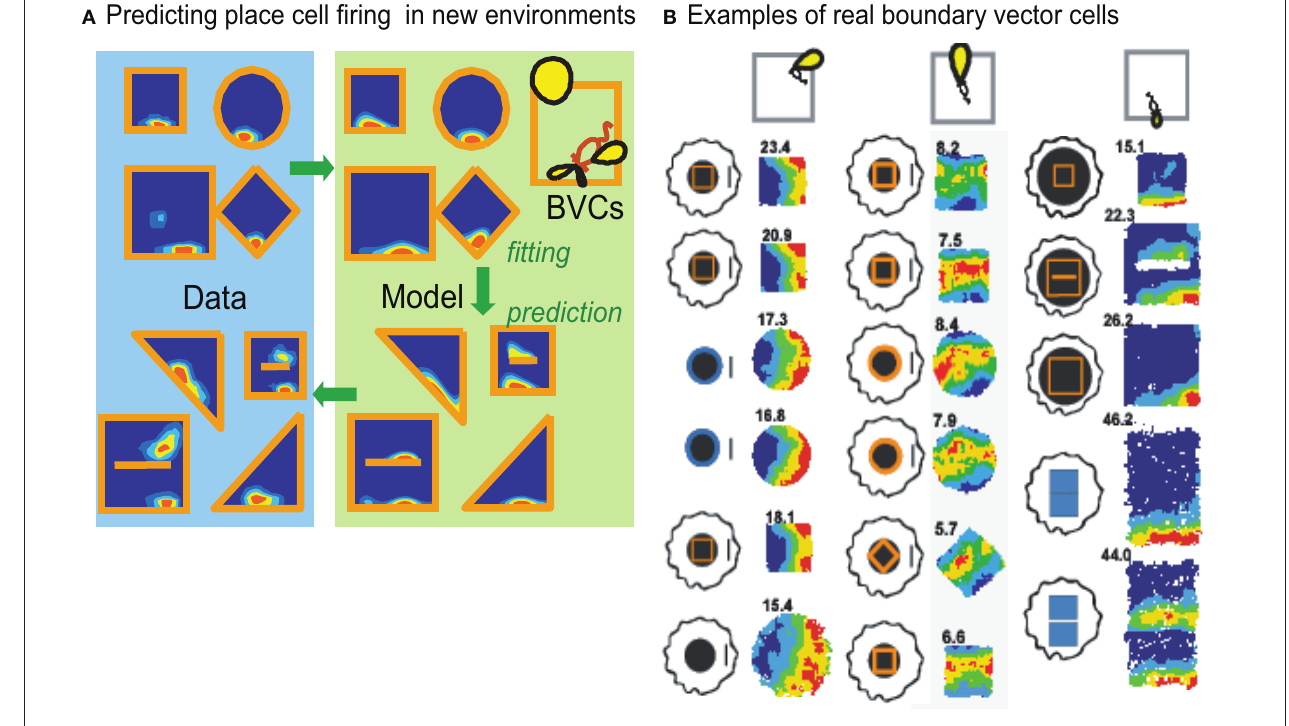
FIGURE 1 | The boundary vector cell (BVC) model of place cell firing Hartley et al. (2000); O’Keefe and Burgess (1996). (A) The likely BVC inputs to a place cell can be inferred from its firing pattern across environments of different shape (left). This can be used to predict its firing pattern in new